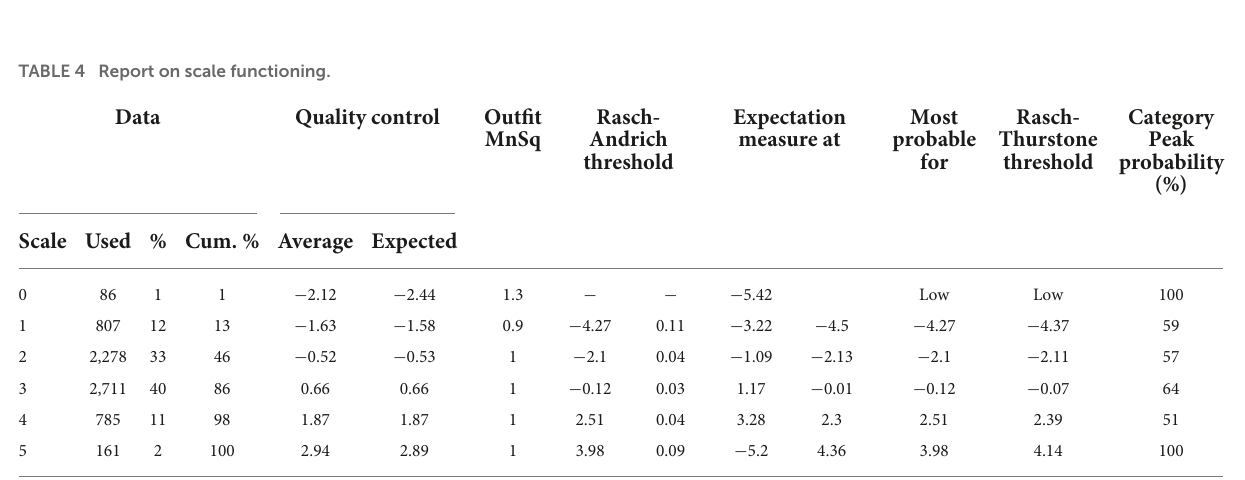
TABLE 4 Report on scale functioning. Data Quality control Outfit